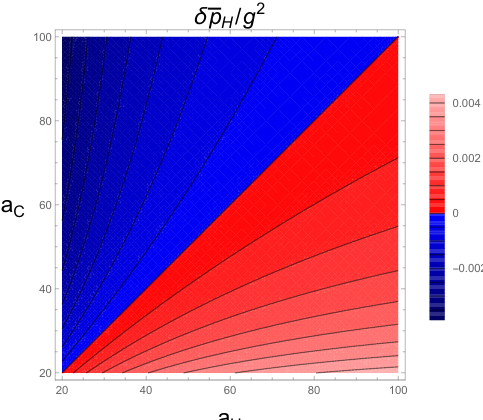
for di(cid:11)erent H > 0, only for H